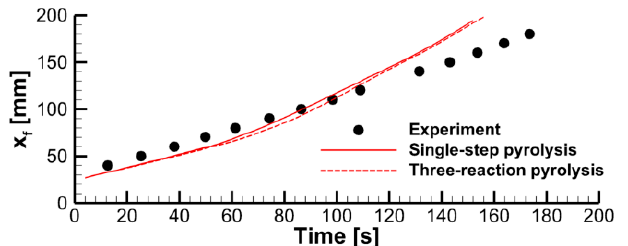
Figure 15. Pyrolysis front coordinate vs. time. Predictions obtained in coupled simulations with two kinetic models of solid pyrolysis are compared with the experimental data.